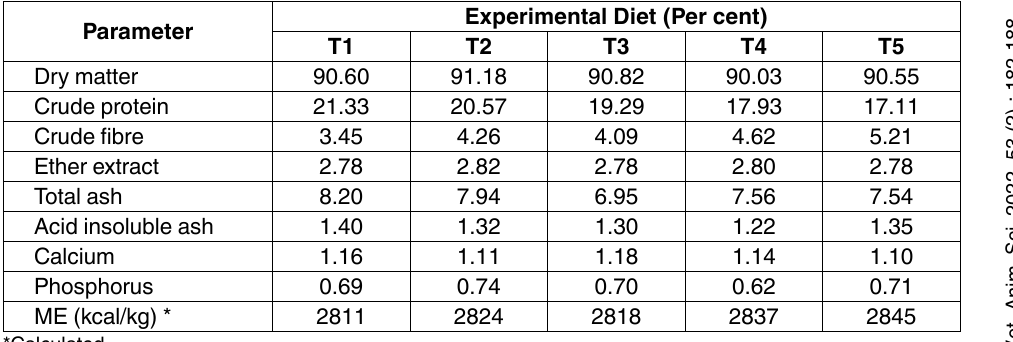
Experimental Diet (Per cent) t1 t2